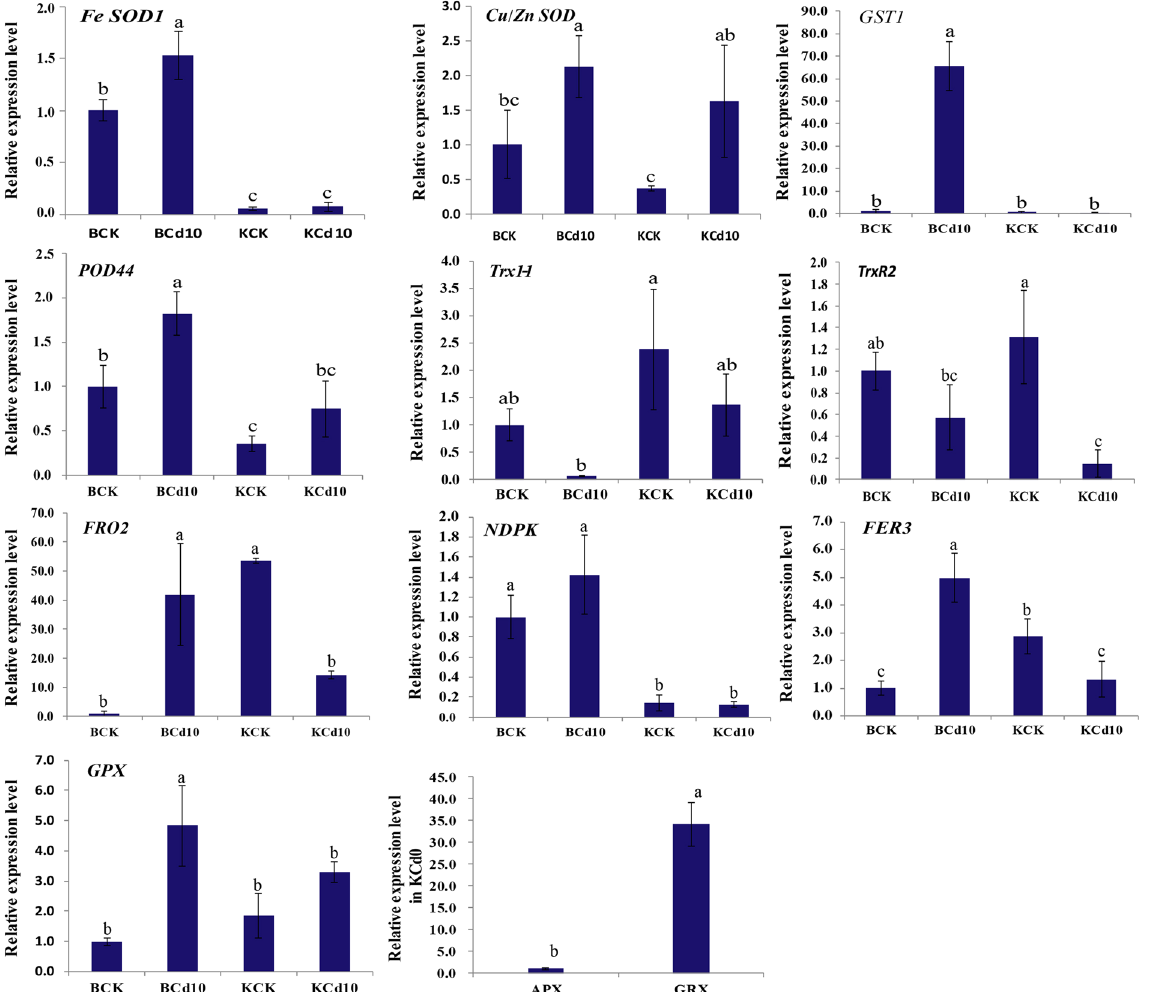
Figure 4. RT-qPCR analyses of 12 ROS scavenging-related genes under the control and Cd treatment in roots of two pak choi cultivars. Each bar represents the mean ± STD of triplicate assays. Values with different letters indicate significant differences at P < 0.05 according to Duncan’s multiple range